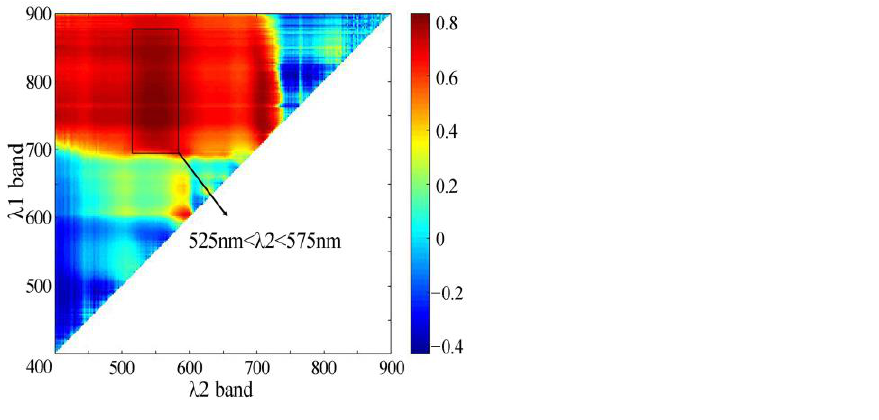
Figure 6. Correlation coefficient matrix between TSP concentration and reflectance ratio combination (high-value area of correlation is enclosed by a black box). Table 10. Comparison of retrieval results for two-band TSP ratio models.